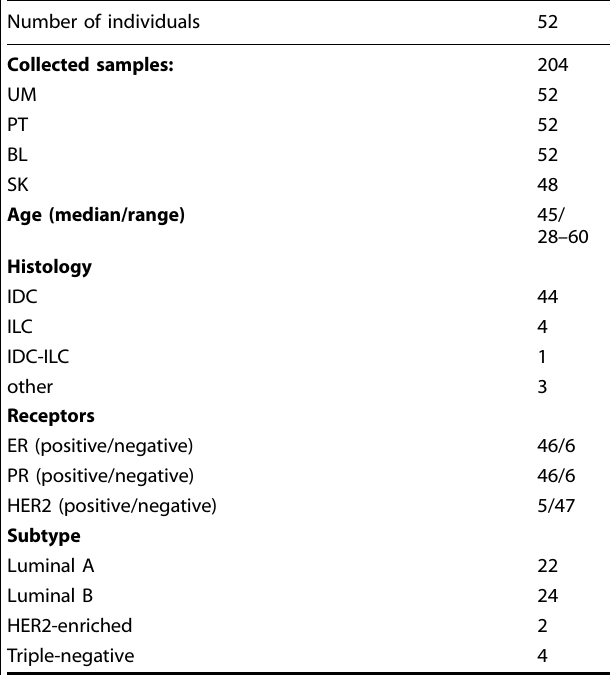
Table 1. Summarized clinicopathological features of sporadic breast cancer patient